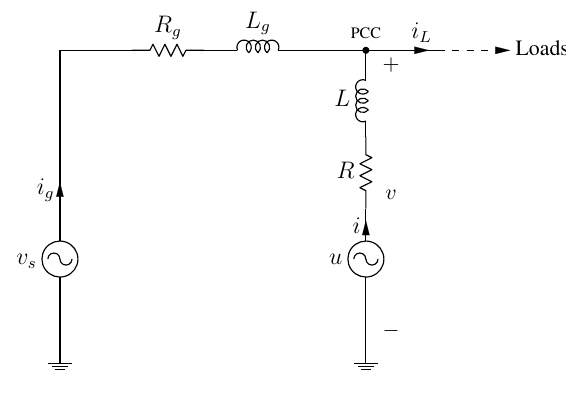
Figure 2. One-line equivalent circuit of the DSTATCOM.